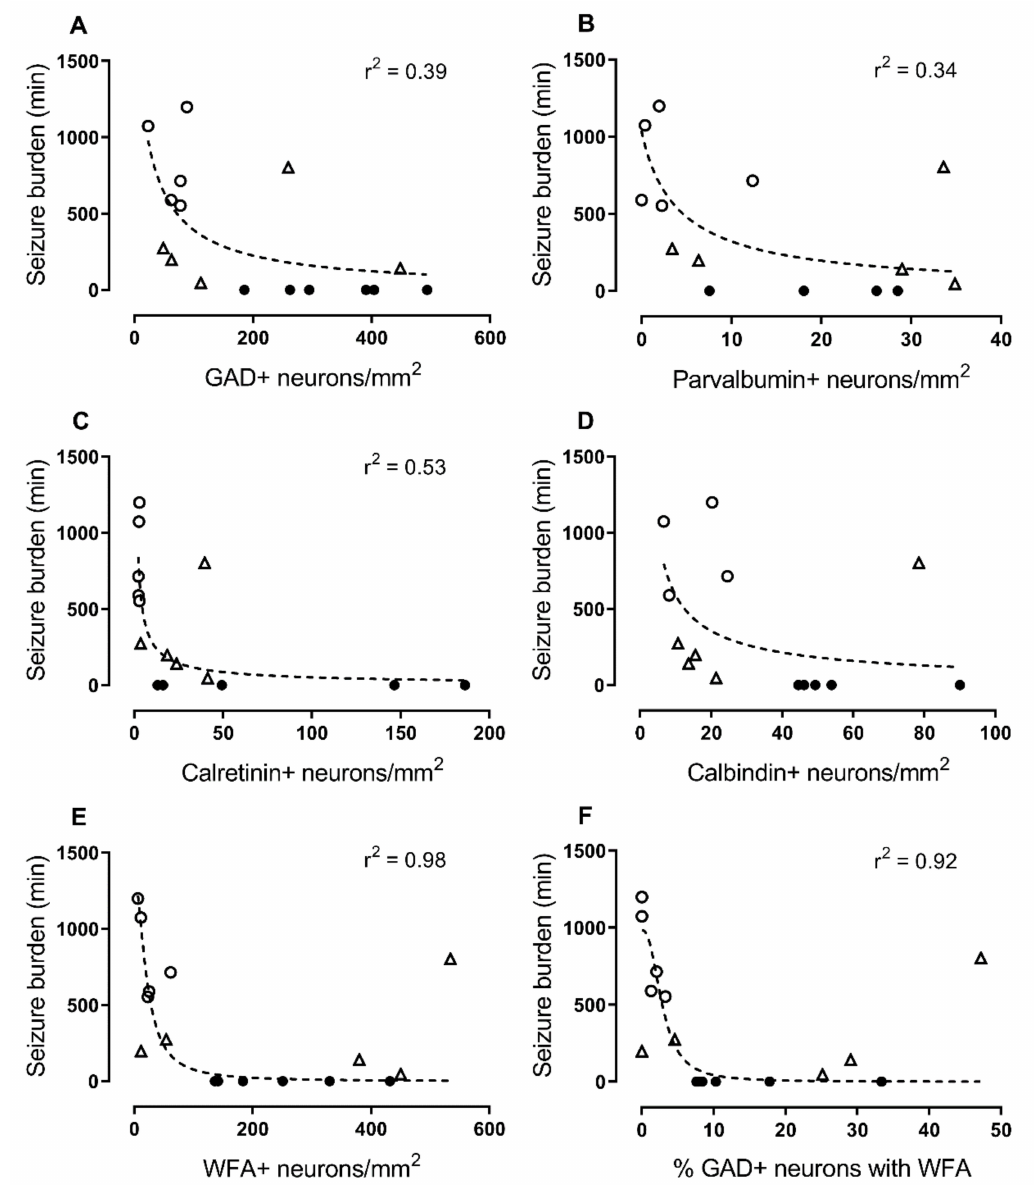
Figure 6. Nonlinear regression (sigmoidal curve fit) of the relationship of interneurons and perineuronal nets (PNNs) with total seizure burden (min): ( A ) Glutamate decarboxylase (GAD) + , ( B ) parvalbumin + , ( C ) calretinin + , ( D ) calbindin + interneuron density, ( E ) Wisteria floribunda agglutinin (WFA) + neuronal density (i.e., PNNs), and ( F ) the percentage of GAD + neurons with PNNs (WFA + ). Sham control group ( n = 6 animals; closed circles). Ischemia + vehicle group ( n = 5; open circles). Ischemia + peptide group ( n = 5; open